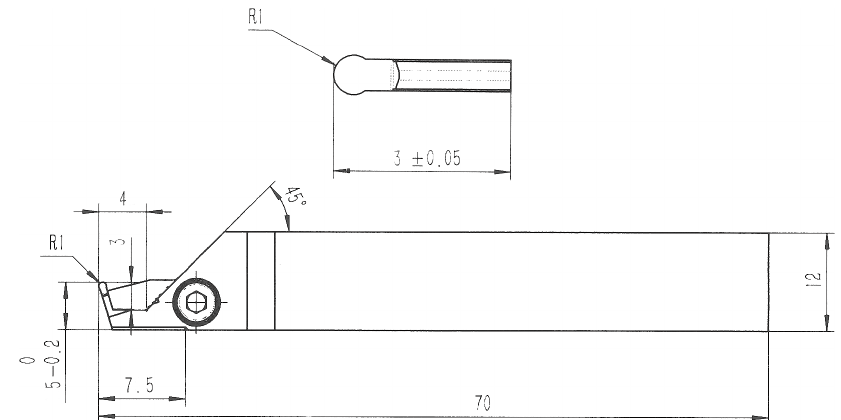
Figure A1. Sample No. A0002 cutting tool scheme.